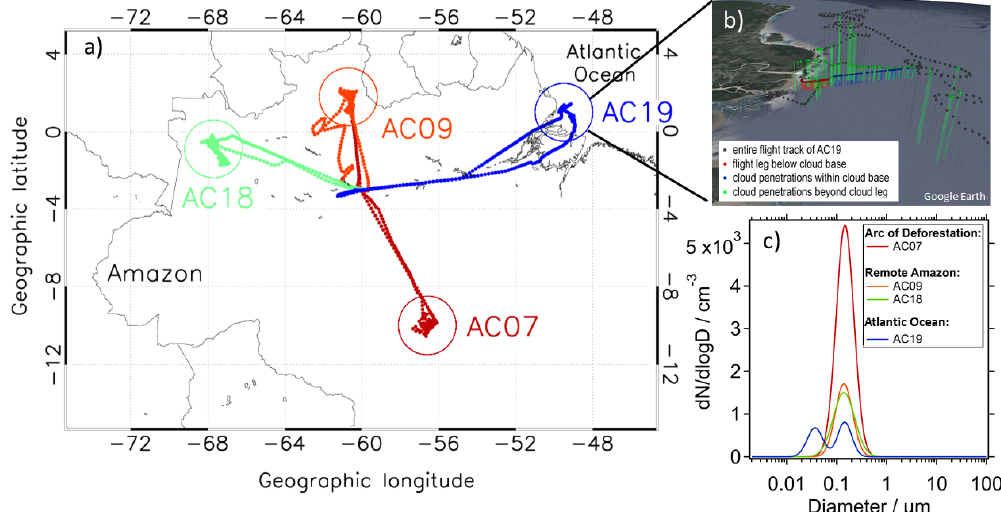
Figure 1. (a) HALO flight tracks during the ACRIDICON–CHUVA experiment, color-coded for the different flights. Circles indicate the region of aerosol and cloud measurements. The average aerosol particle concentration measured below cloud bases during flights AC07, AC09, AC18, and AC19 was 2417, 737, 809, and 428cm − 3 , respectively. (b) Cloud profiling maneuvers during flight AC19 above the Atlantic Ocean near the Amazon River delta shown as three-dimensional profiles corresponding to the two-dimensional profile in panel (a) . Relevant flight segments – particularly legs below cloud base and within cloud base as well as cloud penetrations above cloud base – are emphasized by color-coding. (c) Aerosol size distributions for each flight as used in this